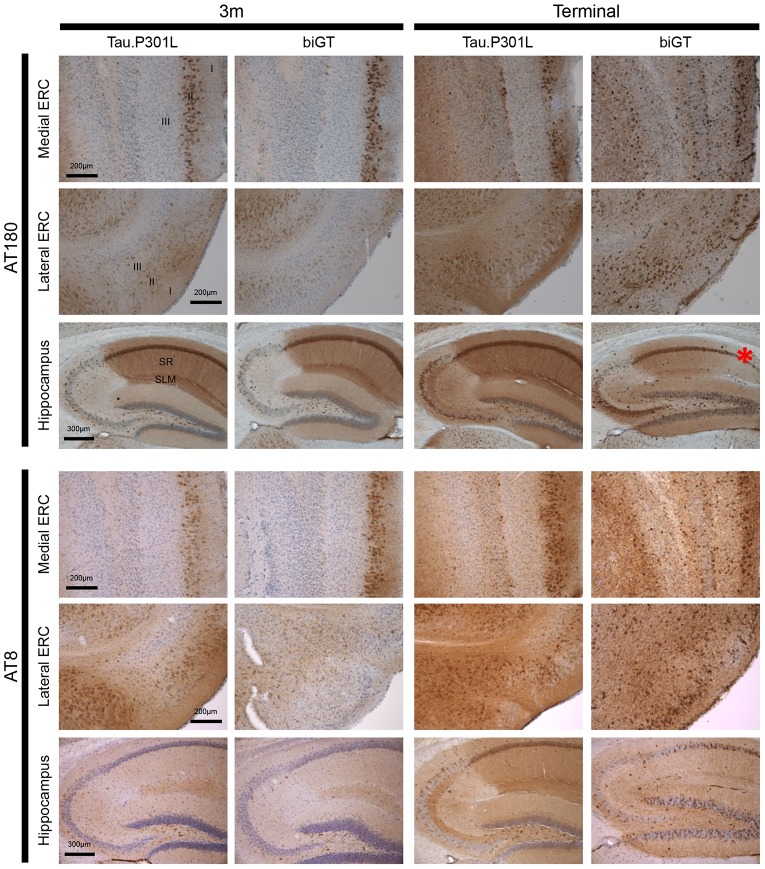
Timeline of phospho-Tau in hippocampal formation of Tau.P301L and biGT mice.IHC for pT231-Tau (AT180) and pS199–202 (AT8) in the sub-regions of the hippocampal formation of Tau.P301L and biGT mice at 3 months of age and at terminal stage (see text for details). Red asterisk marks CA1 pyramidal layer degeneration. Images are representative for the median levels of AT180 and AT8 staining (n = 6–8 mice per age group). Denoted are layers I, II and III of the entorhinal cortex and CA1 hippocampal sub-regions stratum radiatum (SR) and stratum lacunosum moleculare (SLM).